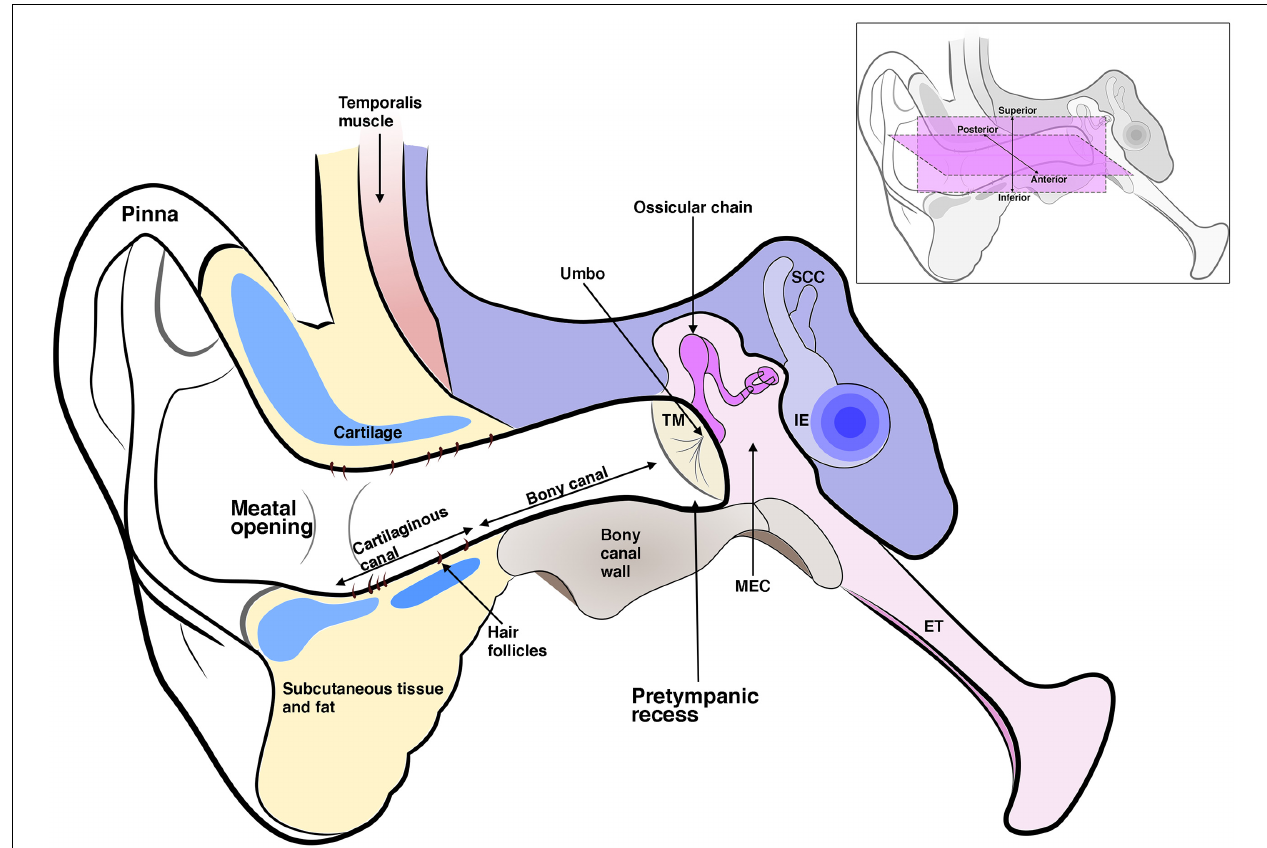
FIGURE 1 | Schematic diagram of the three-part ear; the external ear, which includes the pinna and ear canal; the middle ear which includes the tympanic membrane (TM), middle ear cavity (MEC), and the ossicles. The malleus inserts into the TM at the umbo. The middle ear connects to the nasopharynx via the eustachian tube (ET). The inner ear (IE) includes the cochlea and semi-circular canals. The ear canal is enclosed in its inner two-thirds by a bony wall and its outer third by a cartilaginous wall, which is lined by hair-bearing skin. The ear canal lumen varies in shape but typically has a pretympanic recess and meatal opening. Inset shows anterior, posterior, superior, and inferior axes as referred to in the